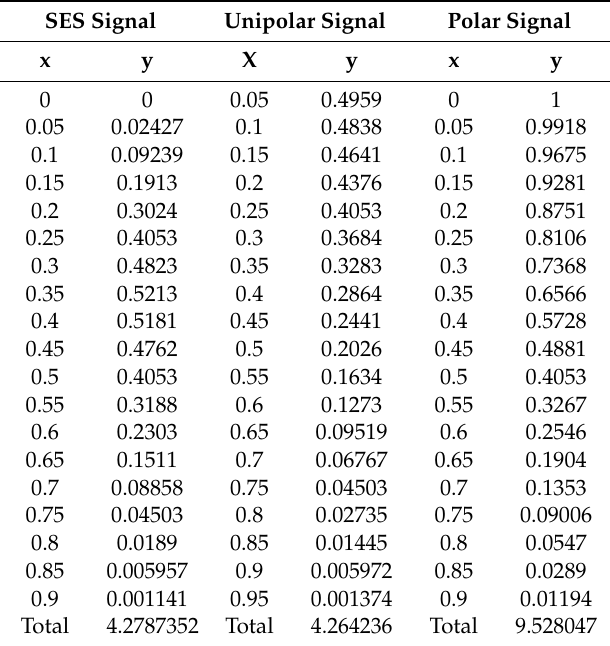
Table 4. SES vs. Unipolar and Polar coordinates.